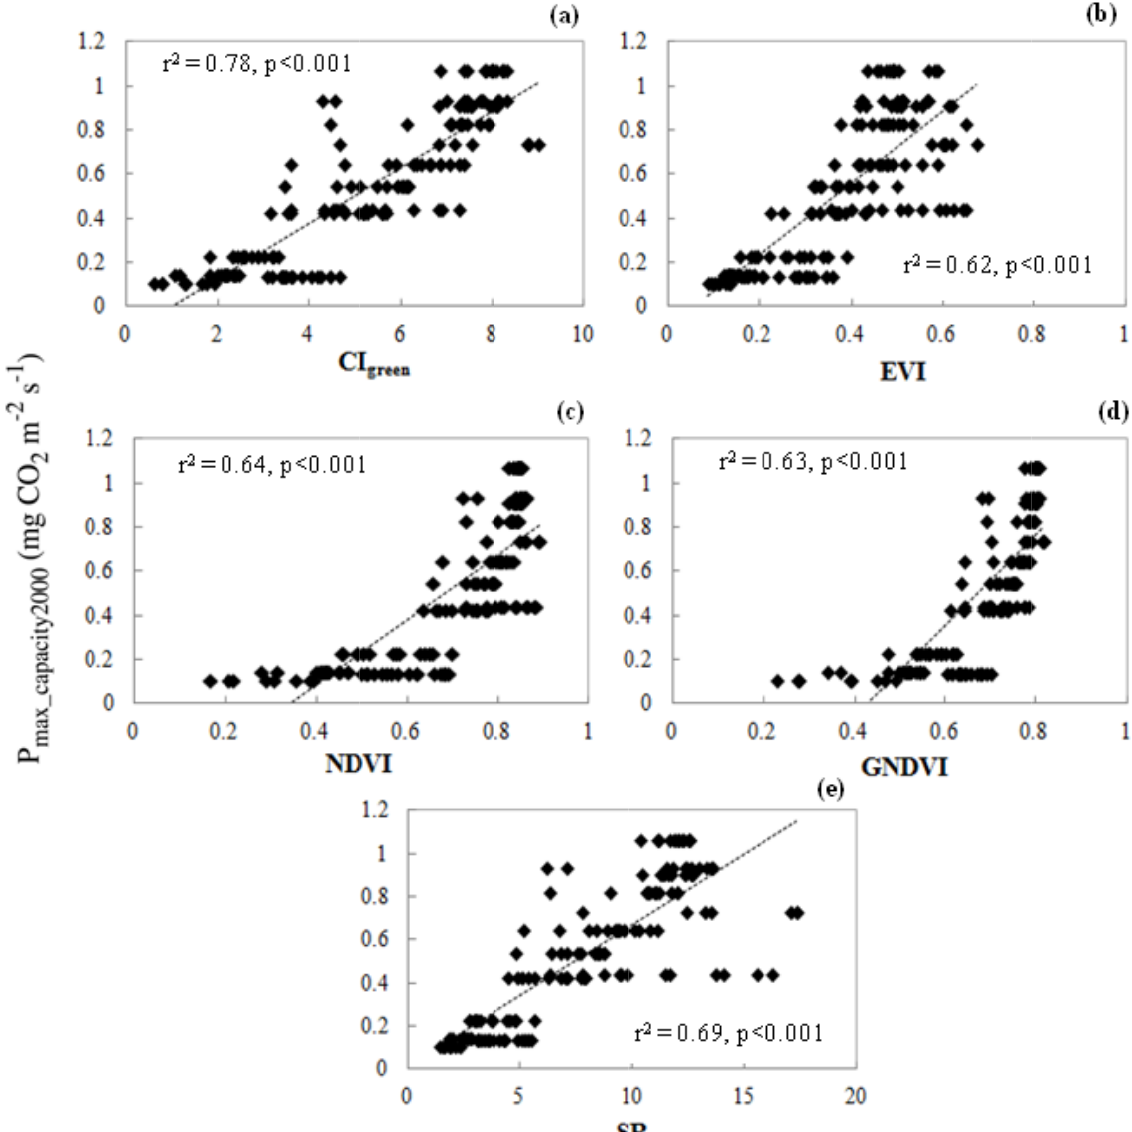
and SR) an correlations 0.59 (P <